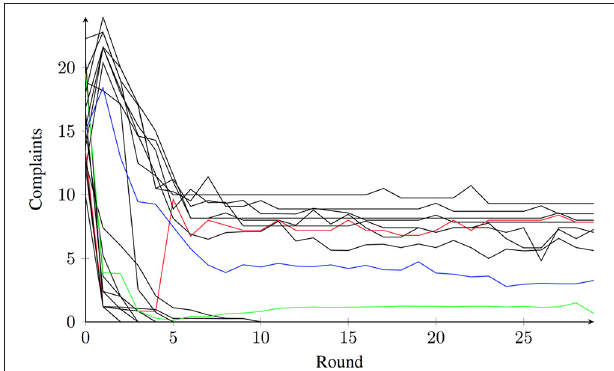
FIGURE 5 | Average number of complaints for each round of 20 simulations using the same configuration. The three highlighted plots (red, blue, and green) are of special interest because they have attributes that distinguish them from the rest. Non-highlighted plots show regular collapsed and stabilized outcomes. Out of the non-highlighted plots, there are 8 stabilized runs and 9 collapsed ones. The three highlighted runs are all classified as stabilized ones. The red plot (top highlighted one) shows the only run where the average number of complaints rapidly falls in the beginning, but recovers and stabilizes around the same level as the normal stabilized runs. The green plot also shows a run that falls rapidly and recovers, but the recovery is at a much lower level. The blue plot shows the lowest stability level with a normal